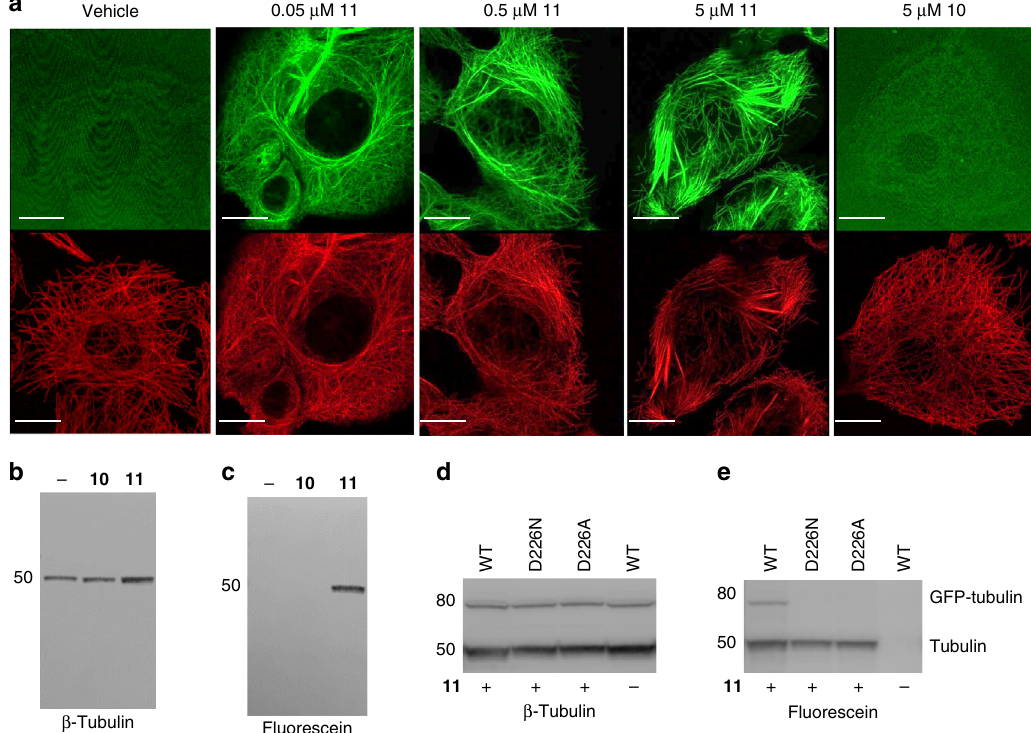
Fig. 6 The taccalonolide epoxide and β -tubulin D226 are critical for covalent binding. a HCC1937 cells were treated with 0.05 – 5 µ M taccalonolide probes with ( 11 ) or without ( 10 ) the 22,23-epoxide for 24 h. Colocalization of taccalonolide probes (green) with β -tubulin immuno fl uorescence (red) was evaluated by confocal imaging. b , c HCC1937 cells treated with 5 µ M 10 or 11 for 6 h were lysed and subjected to immunoblotting using an anti- β -tubulin antibody b or an anti- fl uorescein antibody c . d , e HeLa cells were transfected with GFP-tagged TUBB1 constructs with indicated mutations then treated with 1 µ M 11 for 8 h. Cell lysates were harvested for immunoblotting. β -tubulin immunoblotting d showed the expression of endogenous tubulin (50 kDa) and the GFP-tubulin constructs (77 kDa). e An anti- fl uorescein antibody was used to detect 11 bound to endogenously expressed β -tubulin (lower band, 50 kDa) and the GFP-tubulin constructs (upper band, 77 kDa). Scale bars = 10 µ m for all images. Source data are provided as a Source Data fi